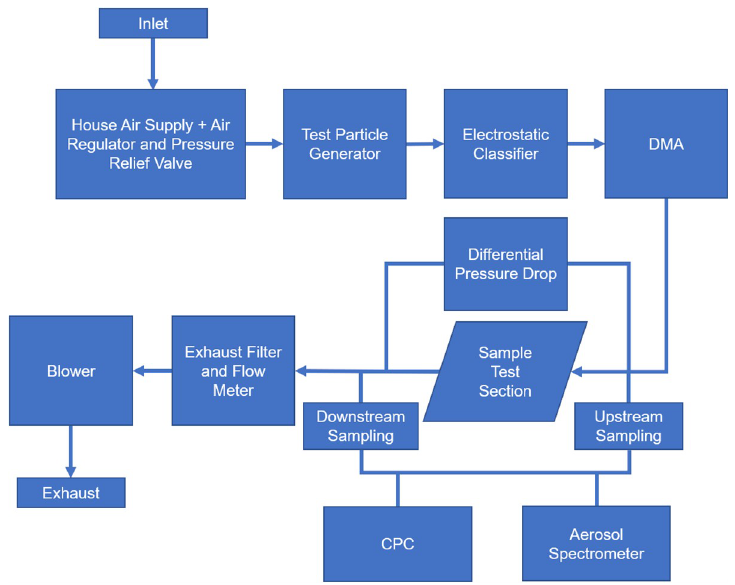
Fig 4. Schematic of Filter Penetration Testbed (FPT). Model 1 cup shape respirator was tested on the FPT. Abbreviations: DMA, differential mobility analyzer; CPC, condensation particle